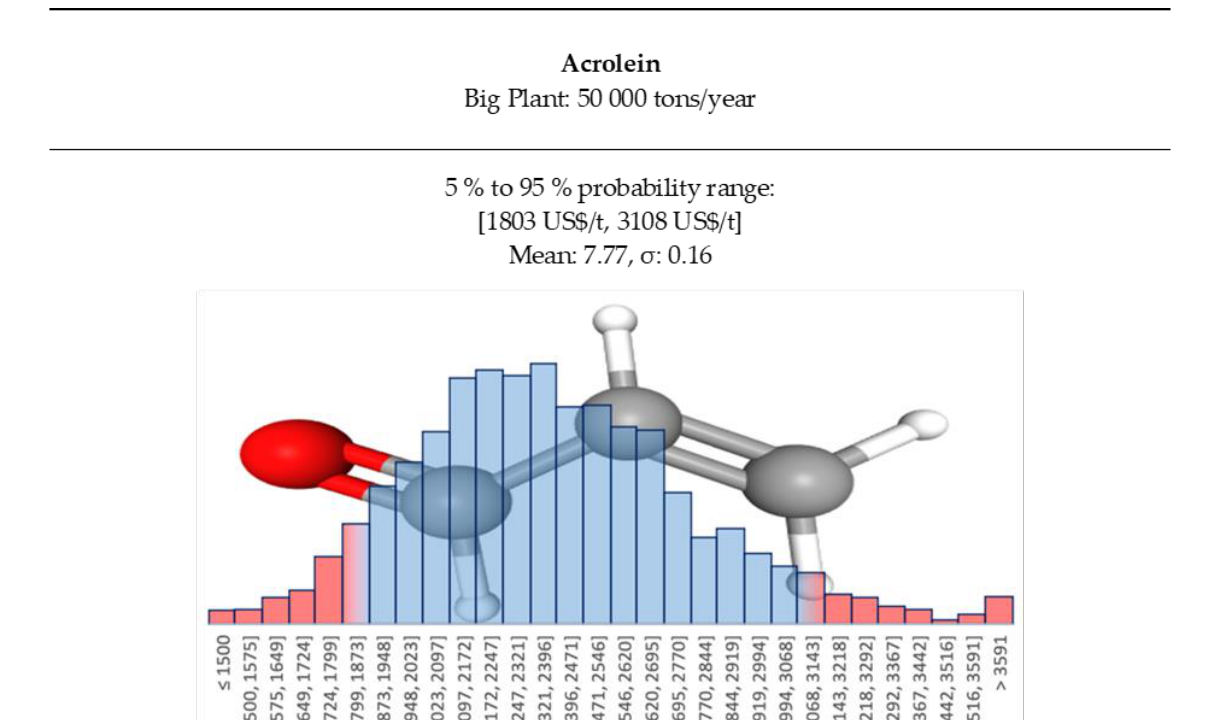
Figure 11. Ethanol and methanol individual price Log-Normal distributions used in the Monte- Carlo simulation.